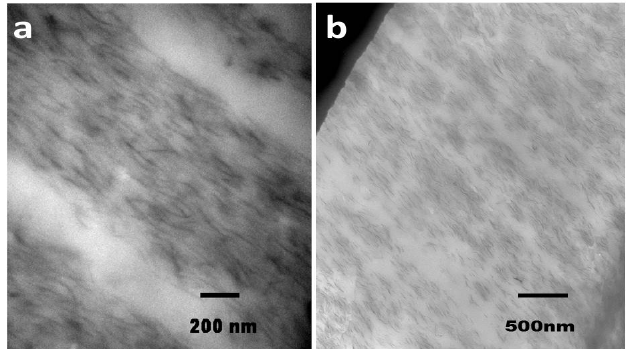
Figure 1. Transmission electron microscopy (TEM) image of ( a ) 2 vol % nanoparticles (NPs) montmorillonite nanocomposite formed by chaotic advection at N = 9 [27]; and ( b ) 5.6 vol % at N = 7, extruded as 150 micron thick films. Dark regions correspond to the NP rich areas and light regions correspond to the matrix polymer.